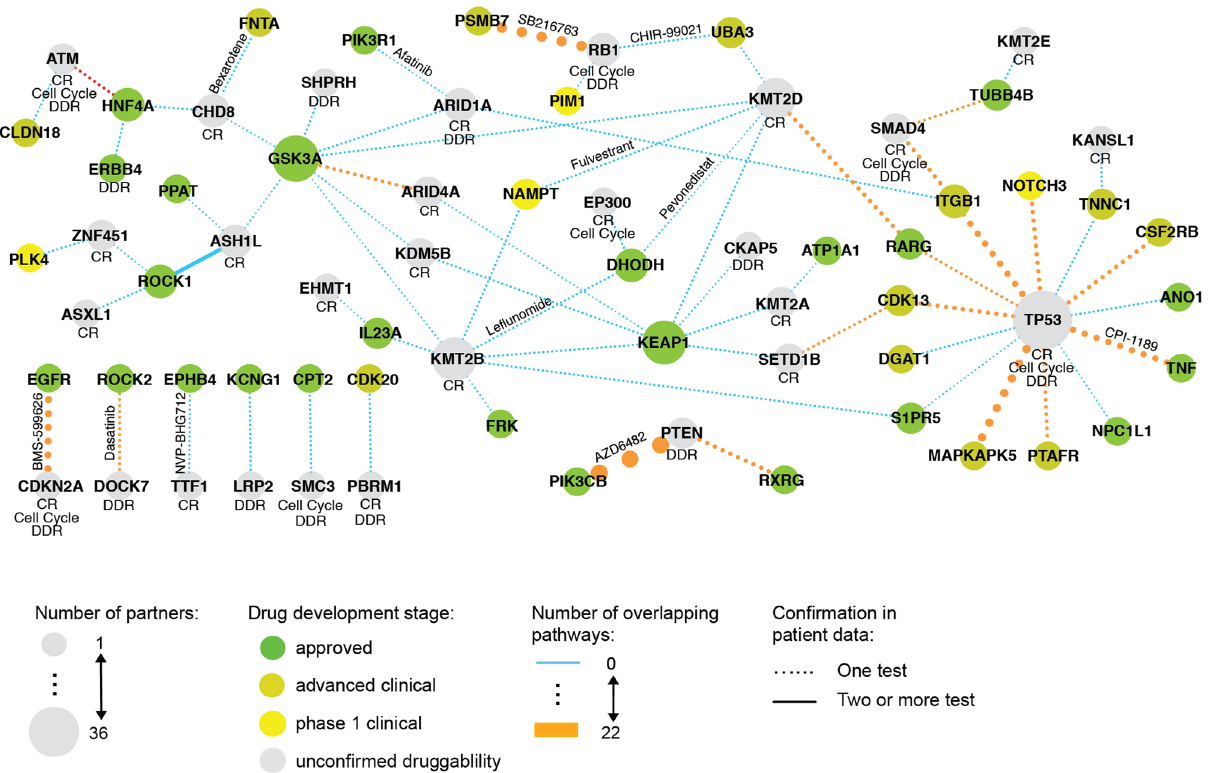
Figure 5. SL evidence network for focus vs druggable genes. The summary network for focus vs druggable genes for the top 50 candidate pairs. Each node represents a gene (gene A or B) and each edge width symbolizes the number of overlapping pathways between two genes. The color of the node represents the drug development stage and the node size indicates the number of gene partners. The drug name is shown next to the edge when the p-value of SPDD test was less than 5%. Confirmation from at least two tests from patient data is marked by a solid line. CR, chromatin remodeling; DDR, DNA damage